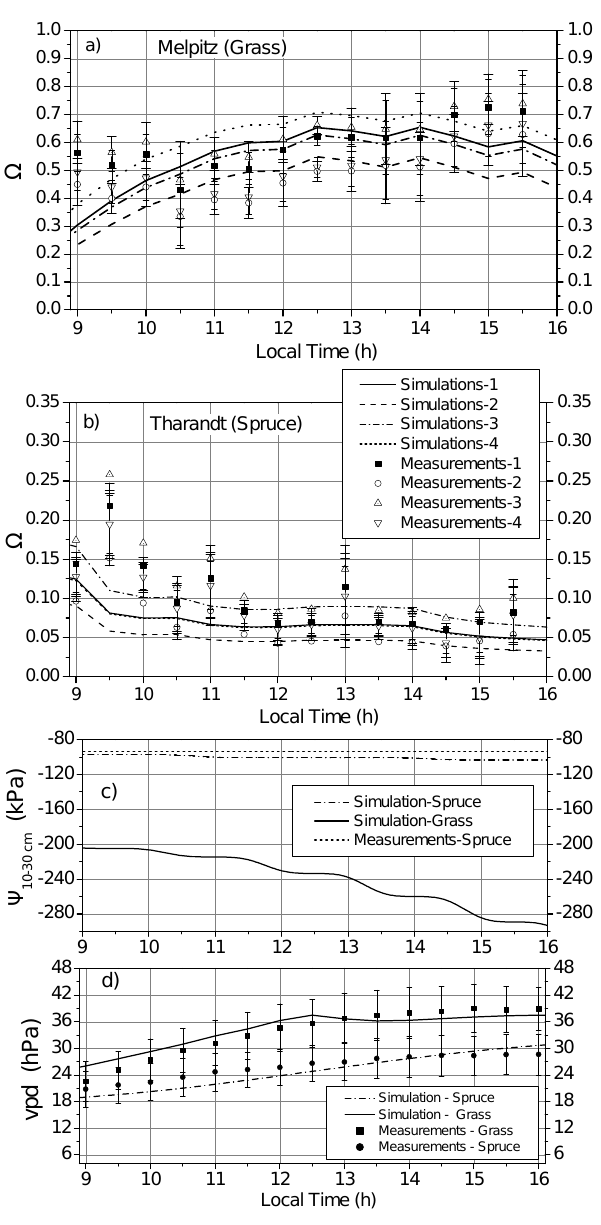
Fig. 11. Daily course of the decoupling coefficient (a, b) for the four different omega equations, as well as soil matrix potential (c) and saturation deficit (d) : HIRVAC simulations for dry soil conditions compared with measurements (period 18 to 21 June 2000) from the spruce site in Tharandt and the grass field site in Melpitz.